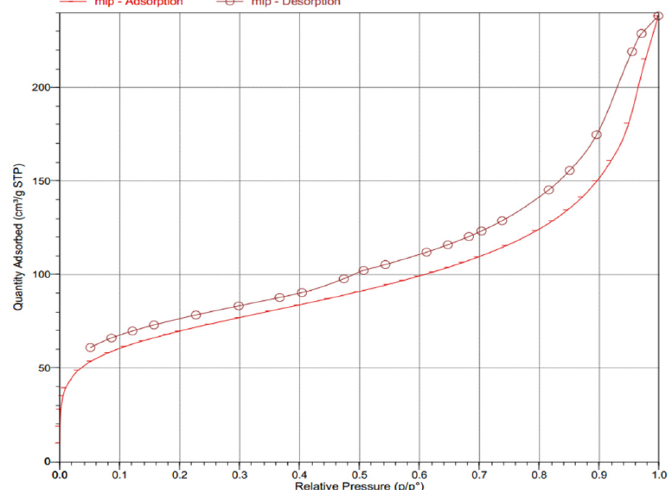
Figure 3. Nitrogen adsorption–desorption isotherms of MG-MIM .